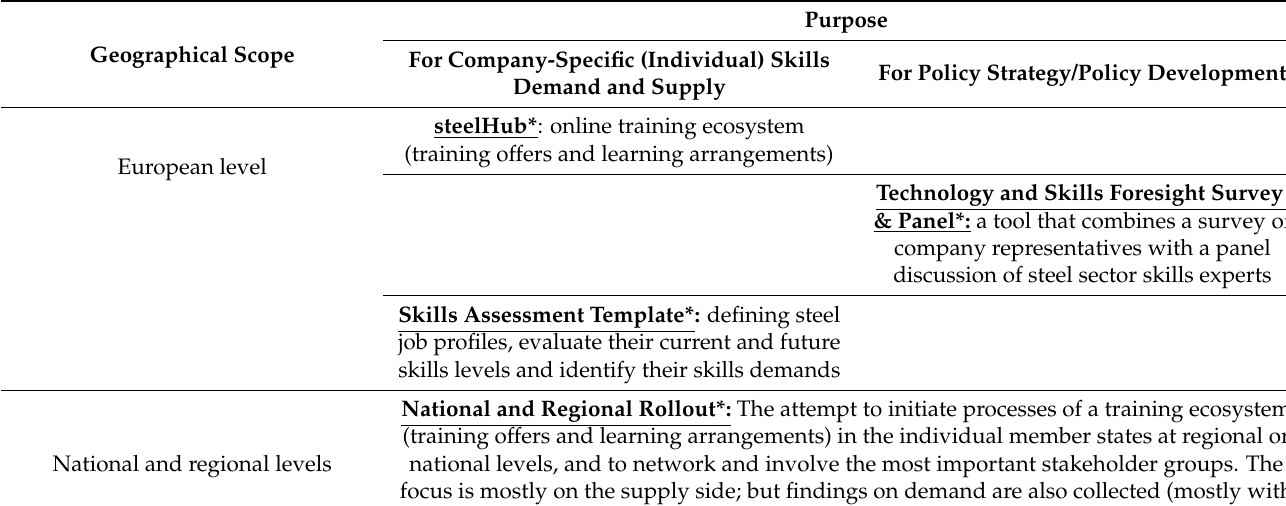
Table 3. Overview of the Analysed